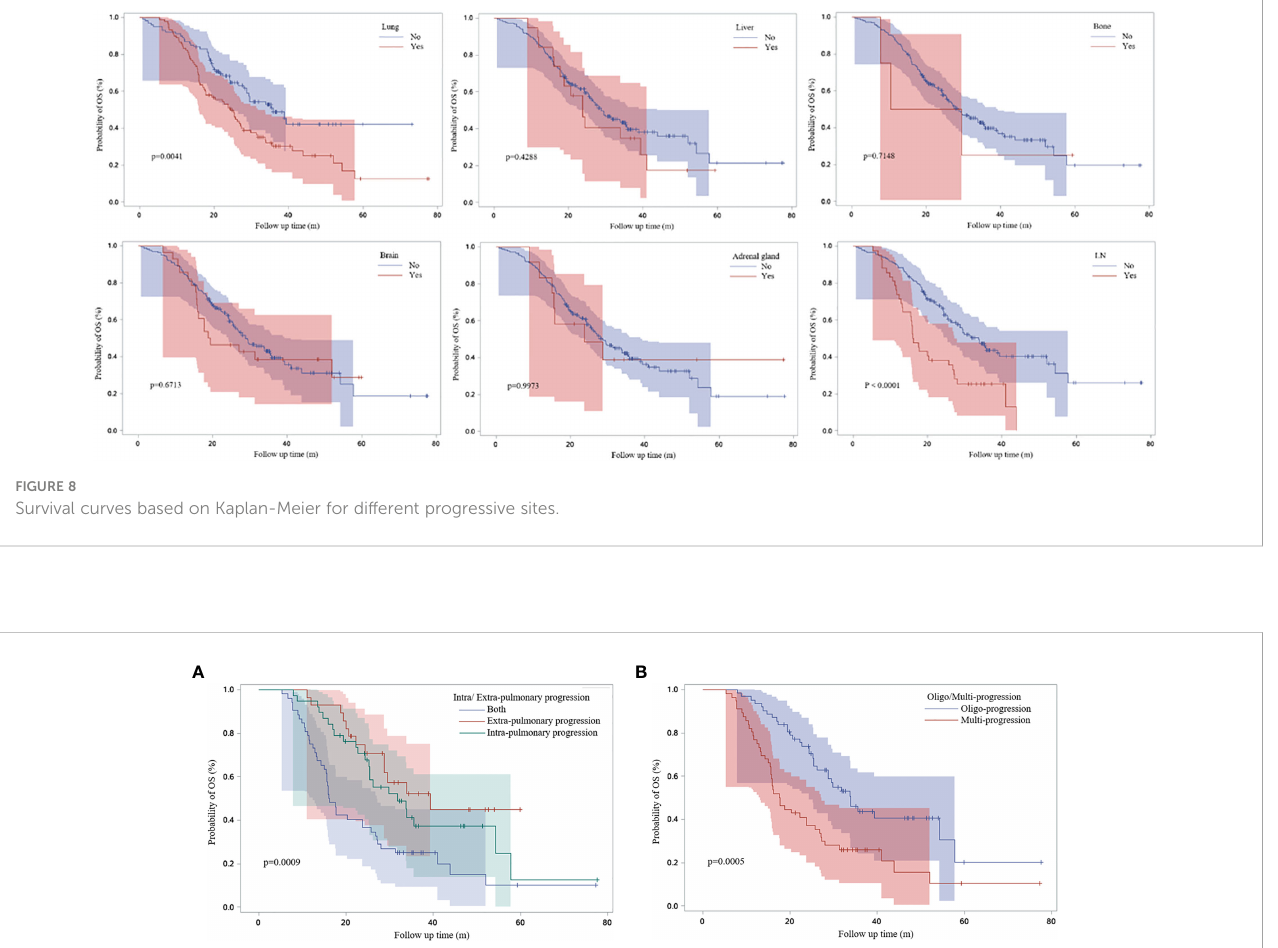
FIGURE 9 Survival curves based on Kaplan-Meier for different characteristics of ICI resistance. (A) Survival curves for patients with intra/extra-pulmonary progression; (B) Survival curves for patients with oligo/multi-progression.